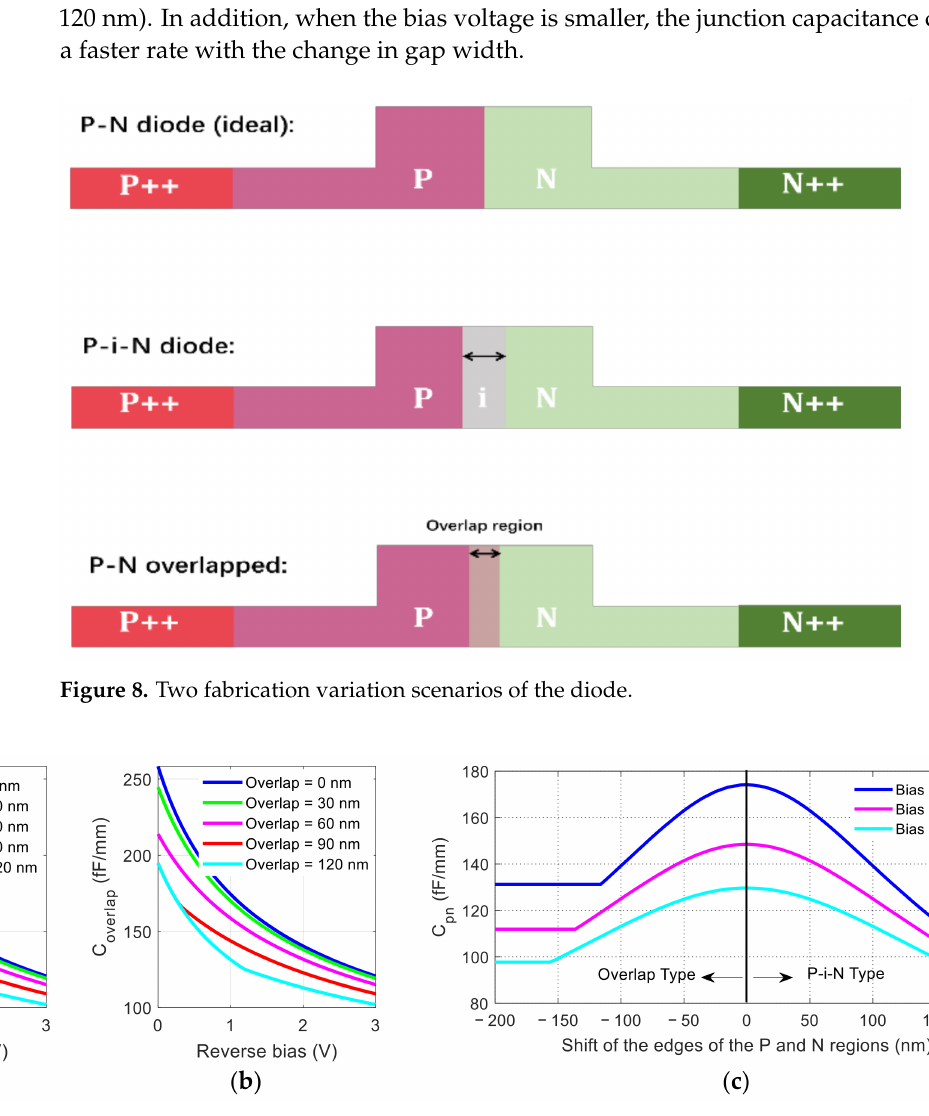
Figure 9. Calculated variation of junction capacitance with bias voltage for ( a ) P-i-N type and ( b ) overlap type; and ( c ) diode under different biases for both